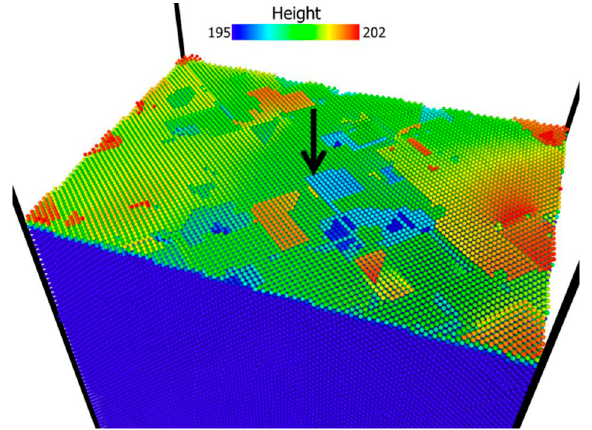
Figure 15. Snapshots of initial surface morphology before indentations at strain level 0.2. Black arrow represents positioning indenter center, which is very close to a surface step.